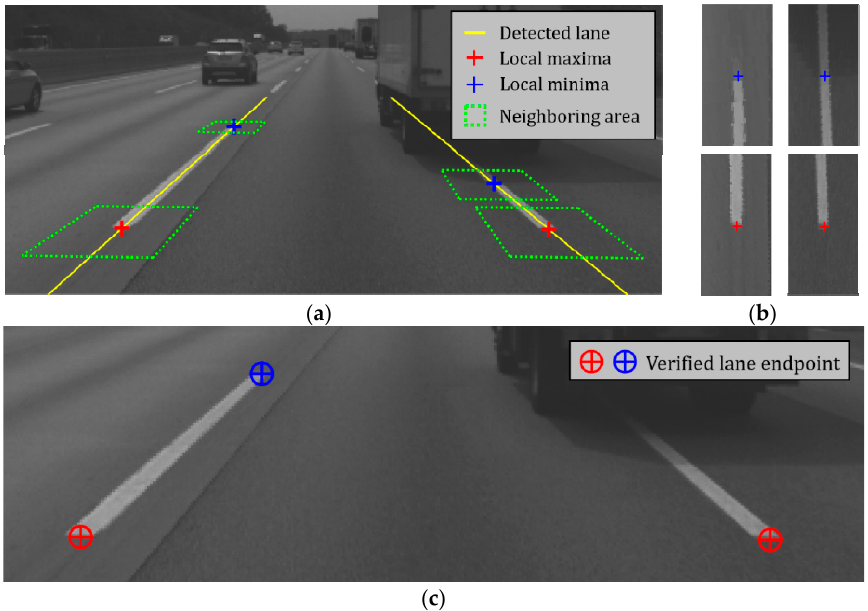
Figure 6. Lane endpoint candidate verification. ( a ) Lane endpoint candidates; ( b ) Bird’s-eye view images generated from lane endpoint candidates; ( c ) Lane endpoint verification result.